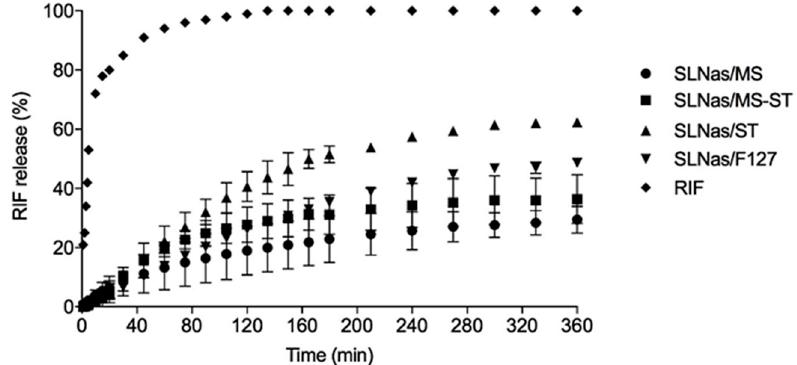
Figure 2. In vitro rifampicin (RIF) dissolution and release from SLNas samples in simulated lung fluid. For some points error bars do not exceed symbol size.